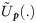
Transformed utility function U˜p(.) (20) as a function of the original one u(.) for different values of Dp≔pD2.The distortion is significant for negative u and for small positive u (i.e. small u compared to Dp) and is all the stronger, the smaller is |uDp|. The transformed utility flattens out for large negative u. U˜p(.) approaches u asymptotically for large positive values (U˜p(.)→u).